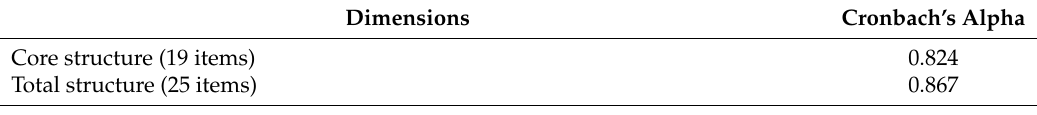
Table 3. Reliability of the core structure, total scale, and four final dimensions including additional items